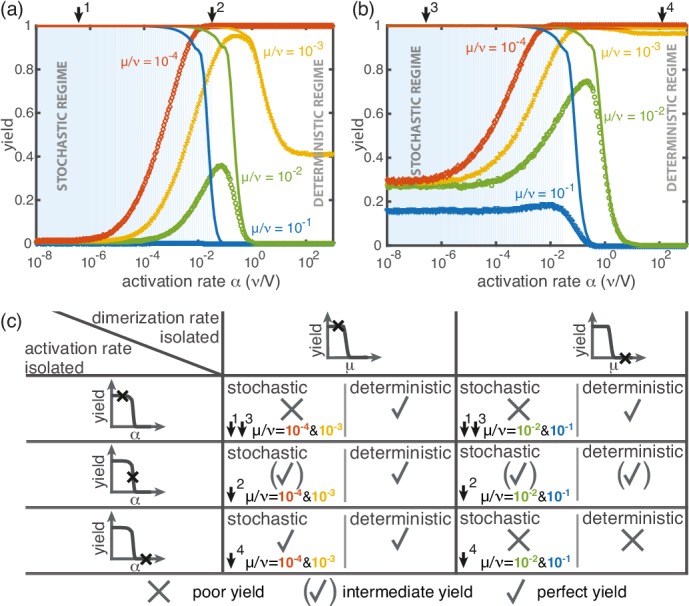
Yield for a combination of slow dimerization and activation.(a, b) Dependence of the yield of the fully heterogeneous system on the activation rate α for N=100 and different values of the dimerization rate (colors/symbols) for L=60 (a) and L=40 (b) (averaged over 1024 ensembles). For large activation rates the yield behaves deterministically (lines). In contrast, for small activation rates, stochastic effects (blue shading) lead to a decrease in yield. Depending on the parameters, the yield maximum is attained in either the deterministic, stochastic or intermediate regime. (c) Table summarizing the qualitative behavior of the yield (poor/intermediate/perfect) for a combination of dimerization and activation rates for both the deterministic and the stochastic limit. The columns correspond to low and high values of the dimerization rate, as indicated by the marker in the corresponding deterministic yield curve at the top of the column. Similarly, the rows correspond to low, intermediate and high activation rates. Arrows and colors indicate where and for which curve this behavior can be observed in (a) and (b). Deviations between the deterministic and stochastic limits are most prominent for low activation rates.